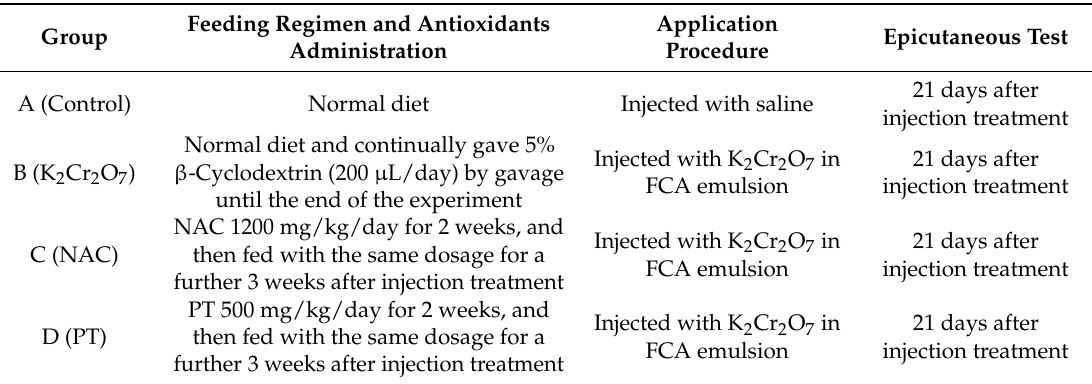
Table 1. The feeding regimen, NAC and pterostilbene (PT) administration and application procedure of female C57BL/6 groups for the epicutaneous